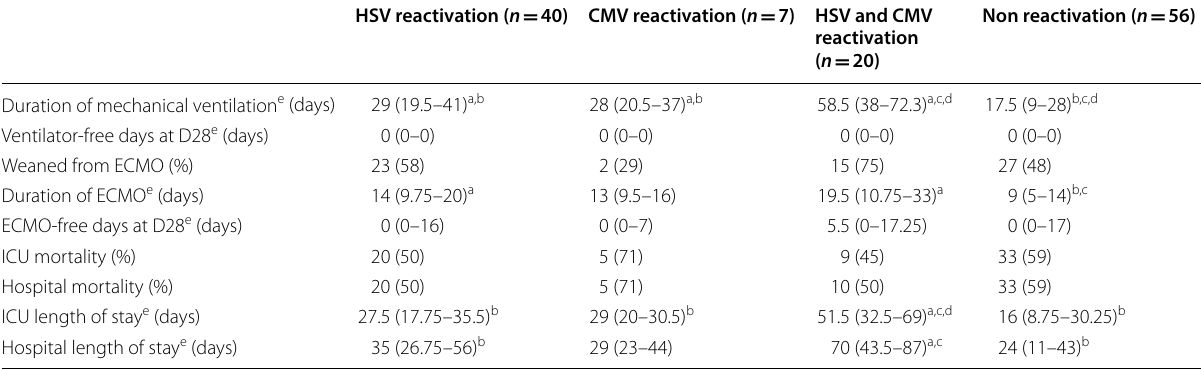
Data are presented as median and interquartile range or absolute value and percentage